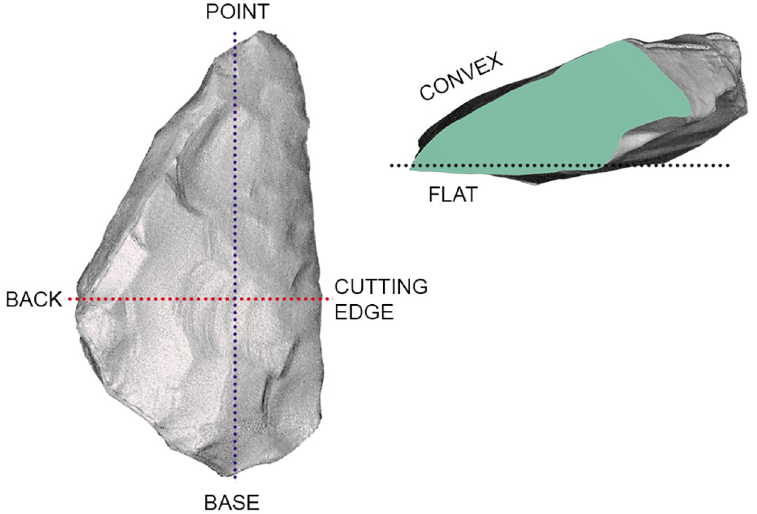
Fig 23. The three main asymmetries of Keilmesser are showed: base/point, back/cutting edge and, viewed in cross- section, flat/convex surfaces.